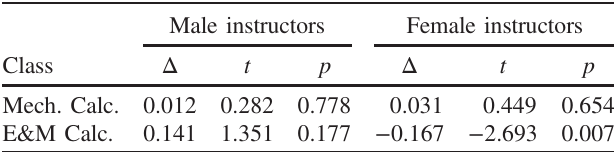
TABLE VIII. Average final letter grade difference between male and female students, Δ , separated by instructor gender, as well as the t tests and significances between these